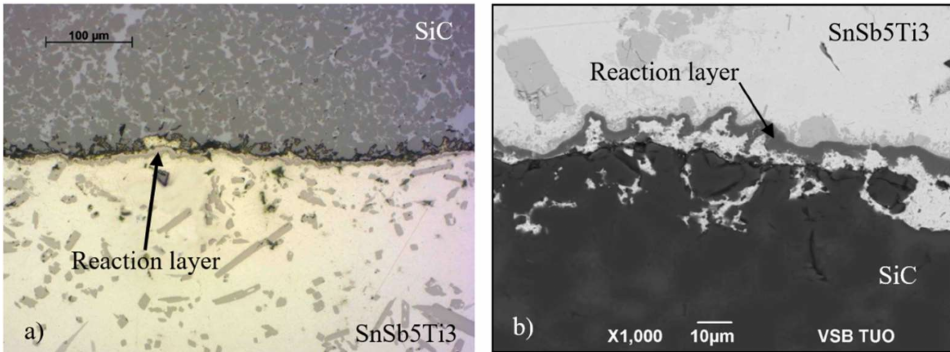
Figure 9. Microstructure on SiC/Sn5Sb3Ti joint boundary of wettability specimen prepared at the temperature of 850 ◦ C ( a ) from the optical microscope; ( b ) from the SEM analysis.